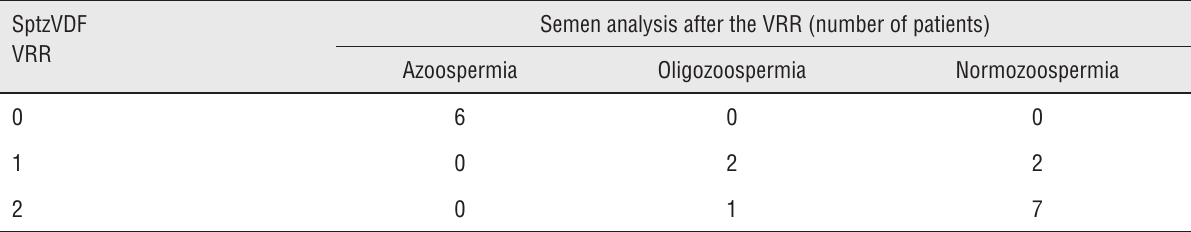
Table 2 – The presence of spermatozoa in the vas deferens fluid in the vasectomy re-reversal and the semen analysis after this